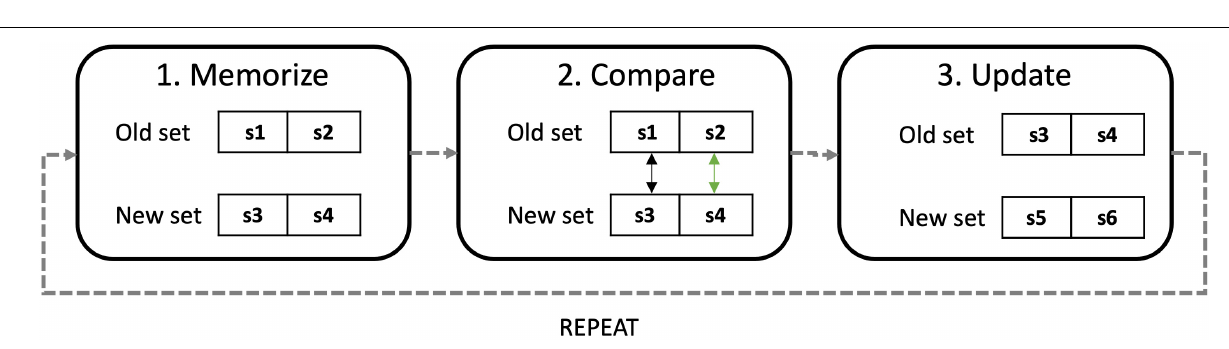
were analyzed separately to fully exploit the data